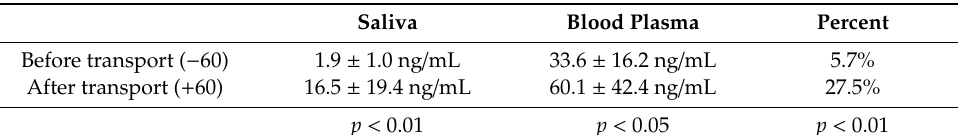
Table 4. Cortisol in saliva and blood plasma of dogs of all three groups combined ( n = 18) before and after a two hour road transport and salivary cortisol concentration expressed as percentage of blood plasma cortisol concentration, values are means ± SEM.